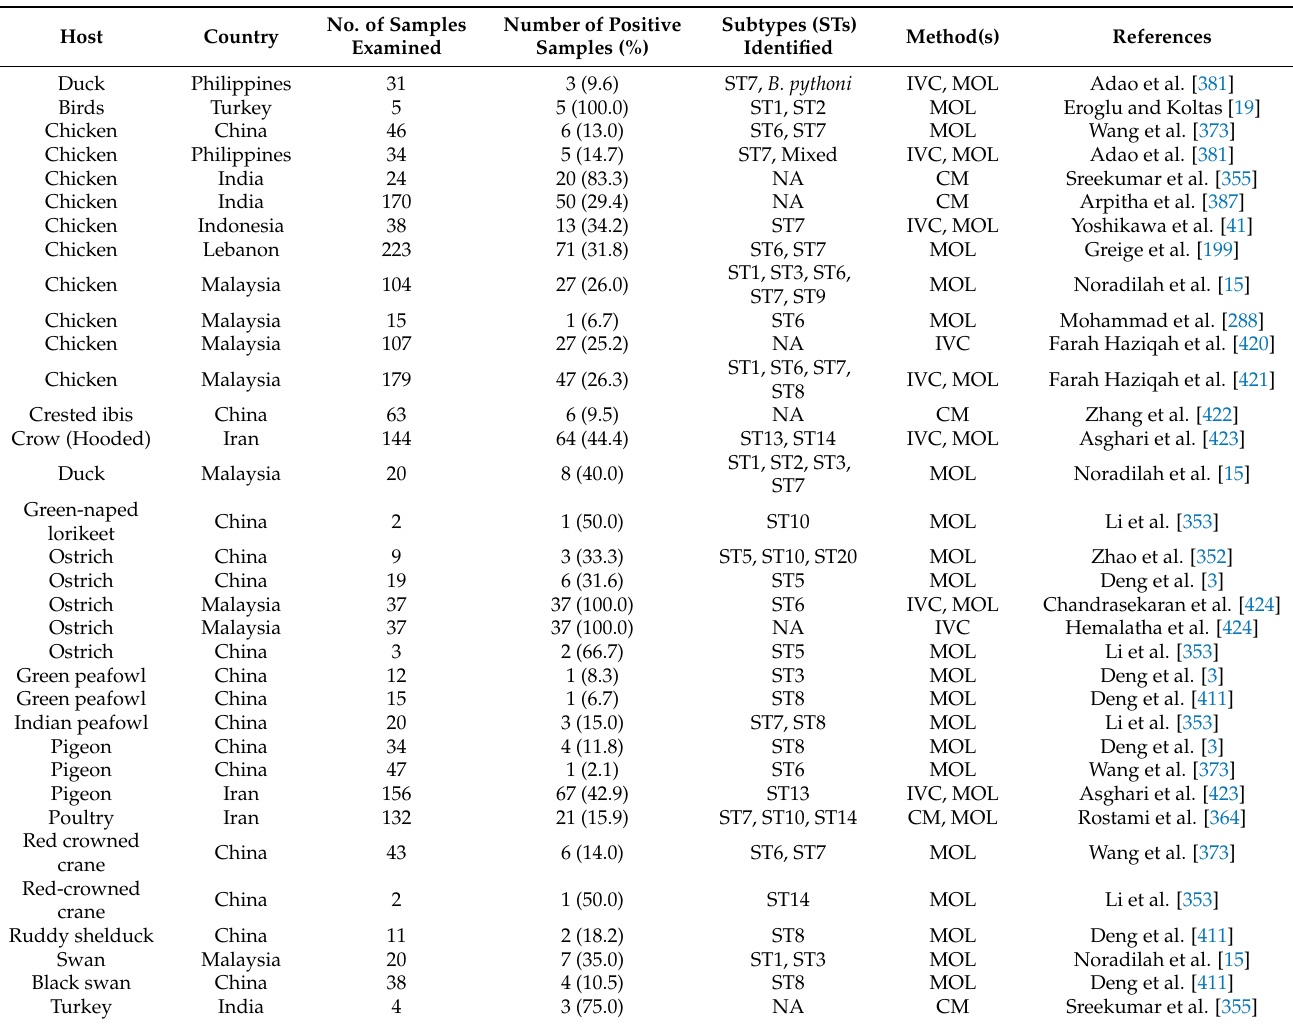
Table 12. Prevalence and subtype distribution of Blastocystis spp. in birds in Asia (2010–2021).